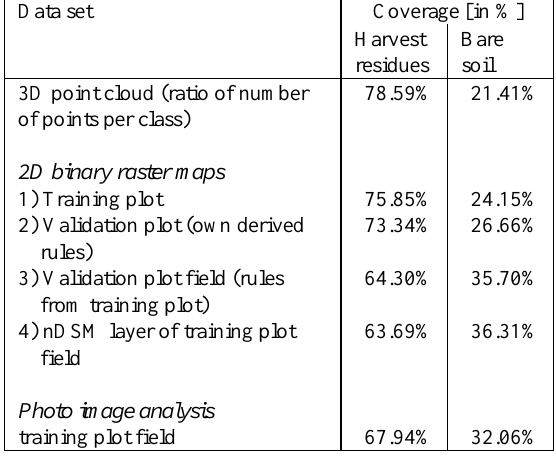
Table 3. Resulting overall coverage values of harvest residues